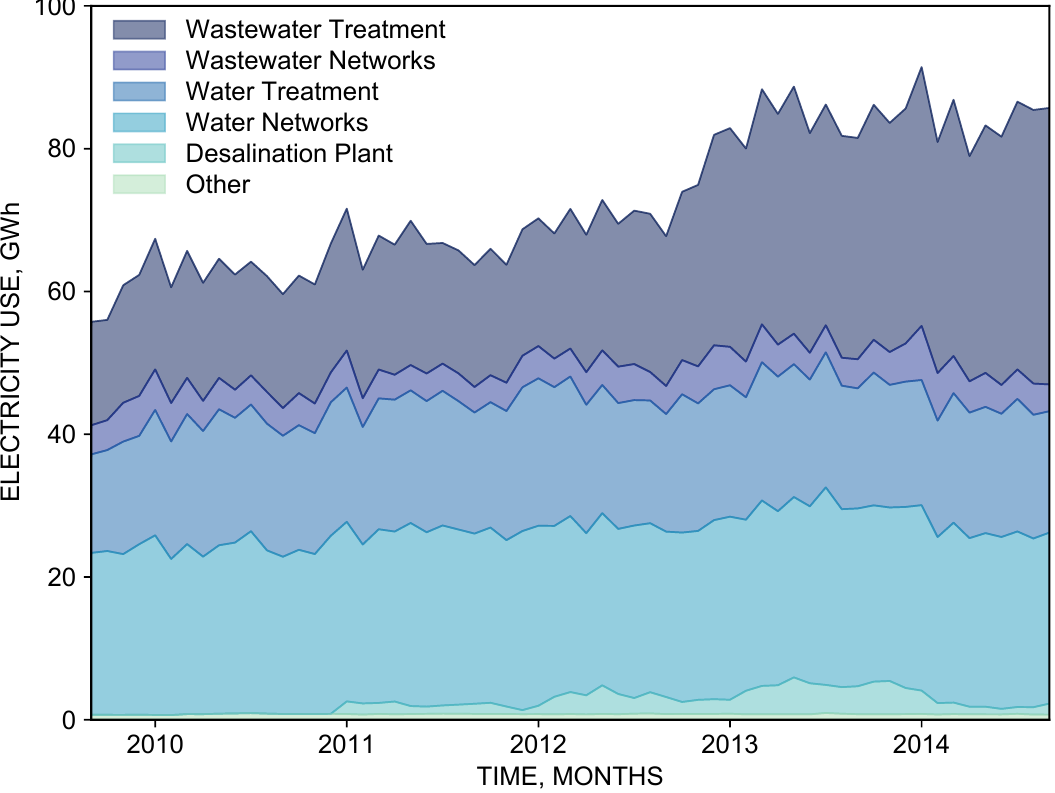
Figure 2. Observed electricity consumption (GWh) between 2009 and 2014 across the Thames Water Utilities Ltd. system. Time series are categorised by different operations within the utilities’